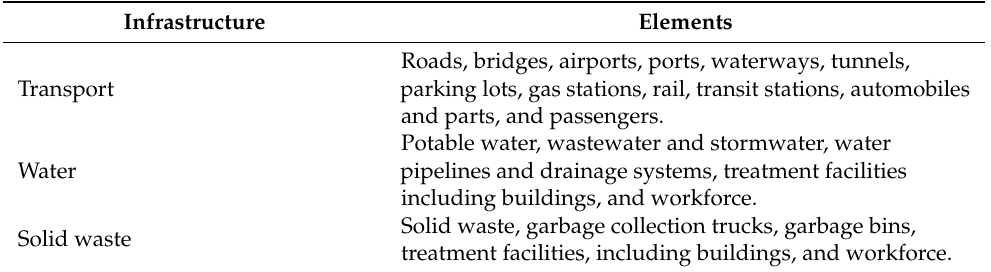
Table 1. Elements of the three infrastructure systems